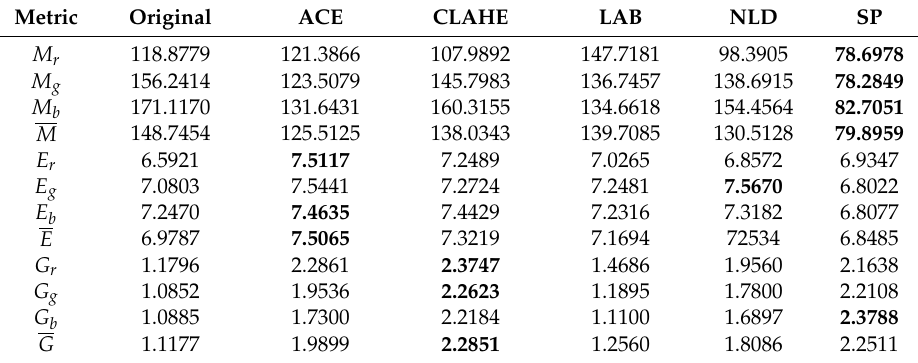
Table 1. Results of evaluation performed on “Baia1” image with the metrics described in Section 5.